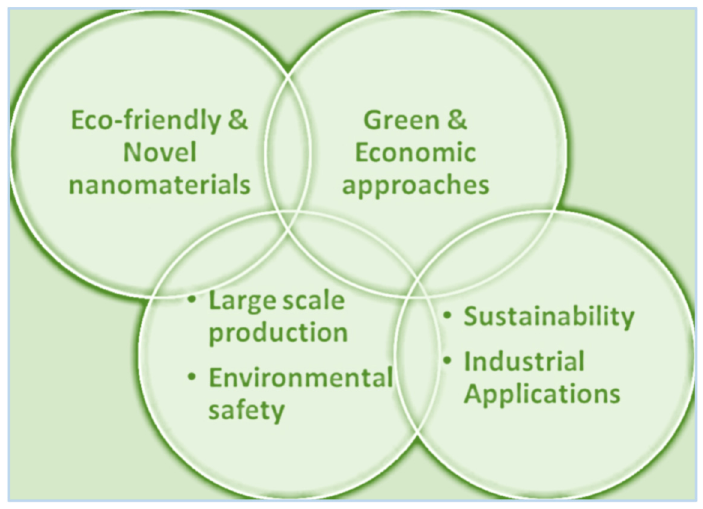
Figure 12. Future perspectives.